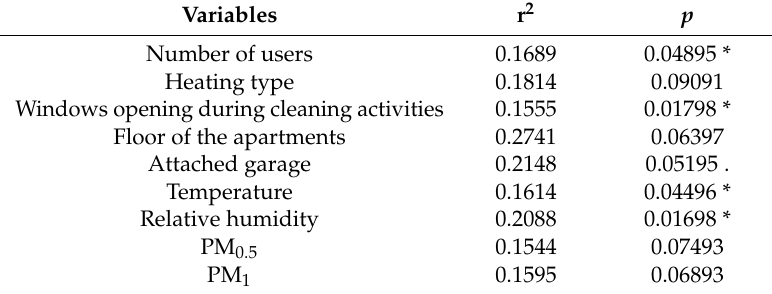
Table 2. Results from envfit.